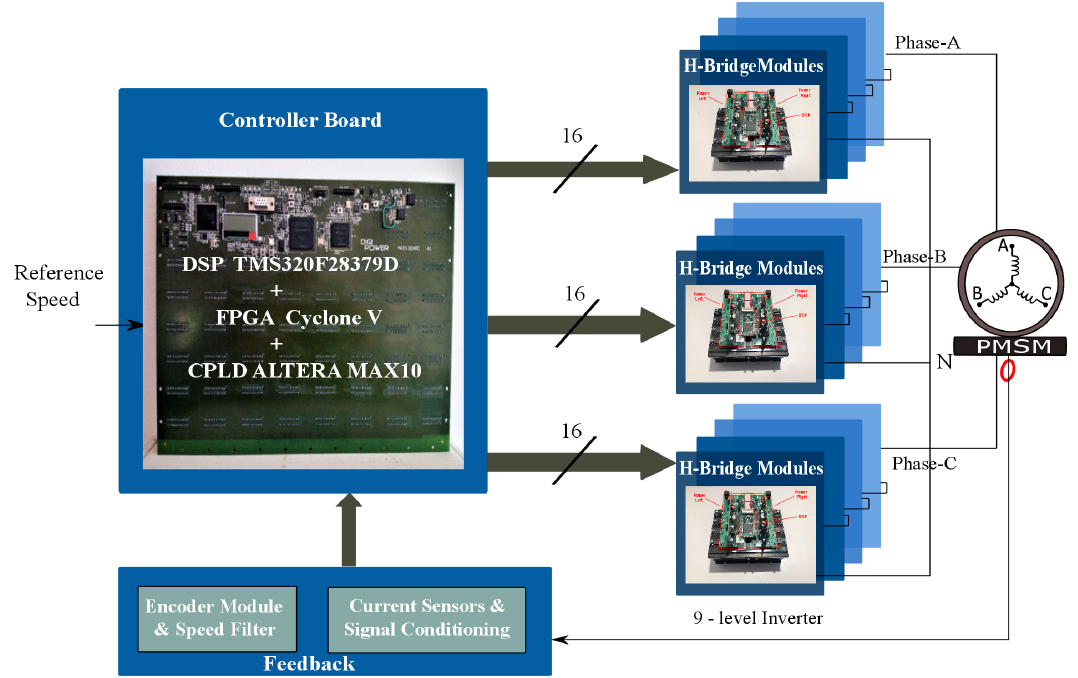
Figure 14. Block diagram of hardware implementation of the 9-level inverter drive.